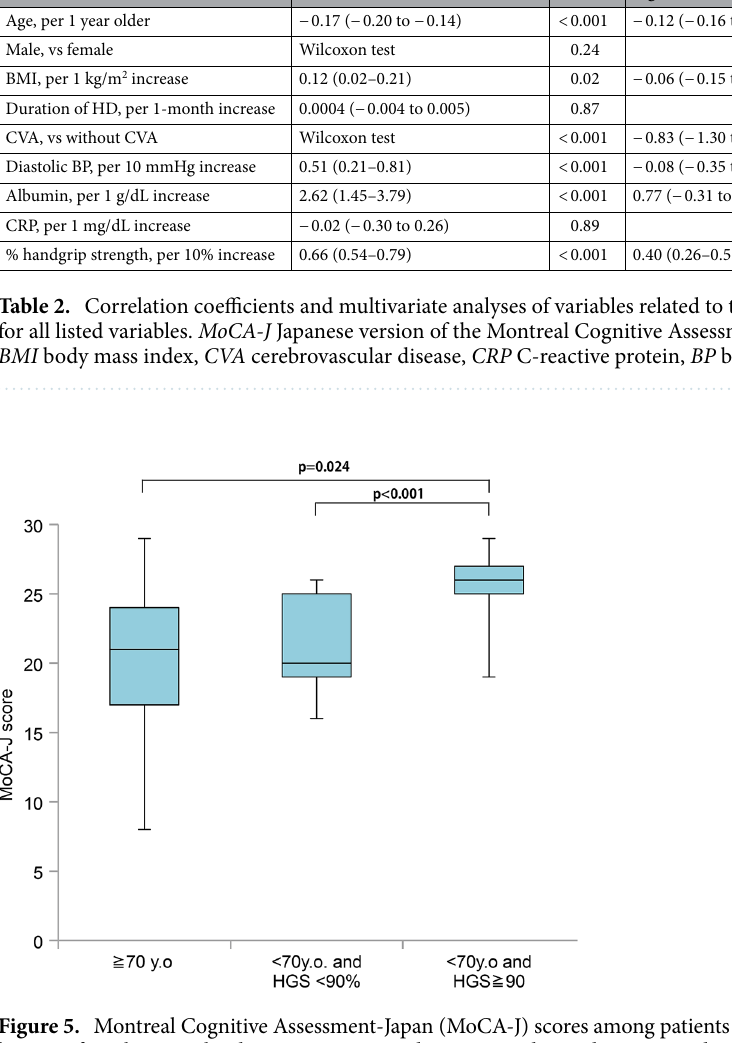
Figure 5. Montreal Cognitive Assessment-Japan (MoCA-J) scores among patients on hemodialysis with a history of cerebrovascular disease. Patients aged 70 years and over demonstrated significantly lower MoCA-J scores than patients aged under 70 years with a handgrip strength ≥ 90% ( p = 0.024). Among those aged under 70 years with a history of cerebrovascular disease, those with a handgrip strength < 90% demonstrated significantly lower MoCA-J scores than those with a handgrip strength ≥ 90% ( p <